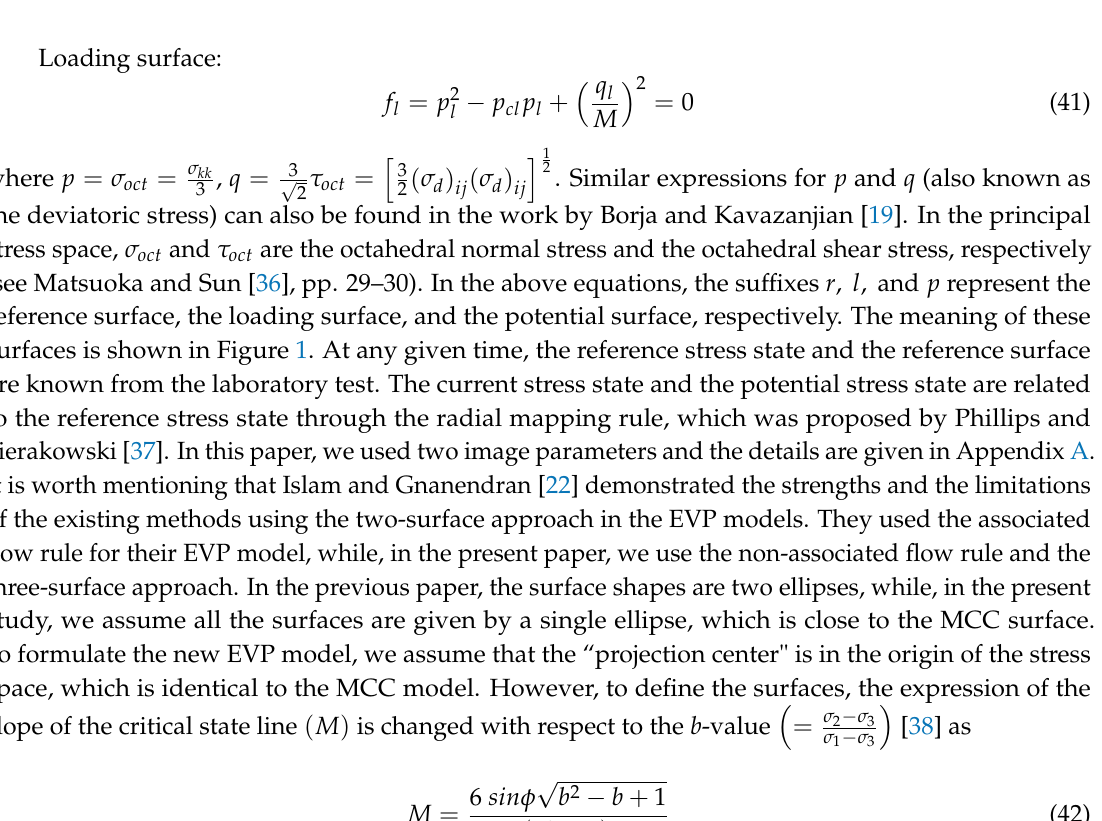
Figure 2. Comparison of the MCC surface and the extended surface in the 𝜋 -plane.